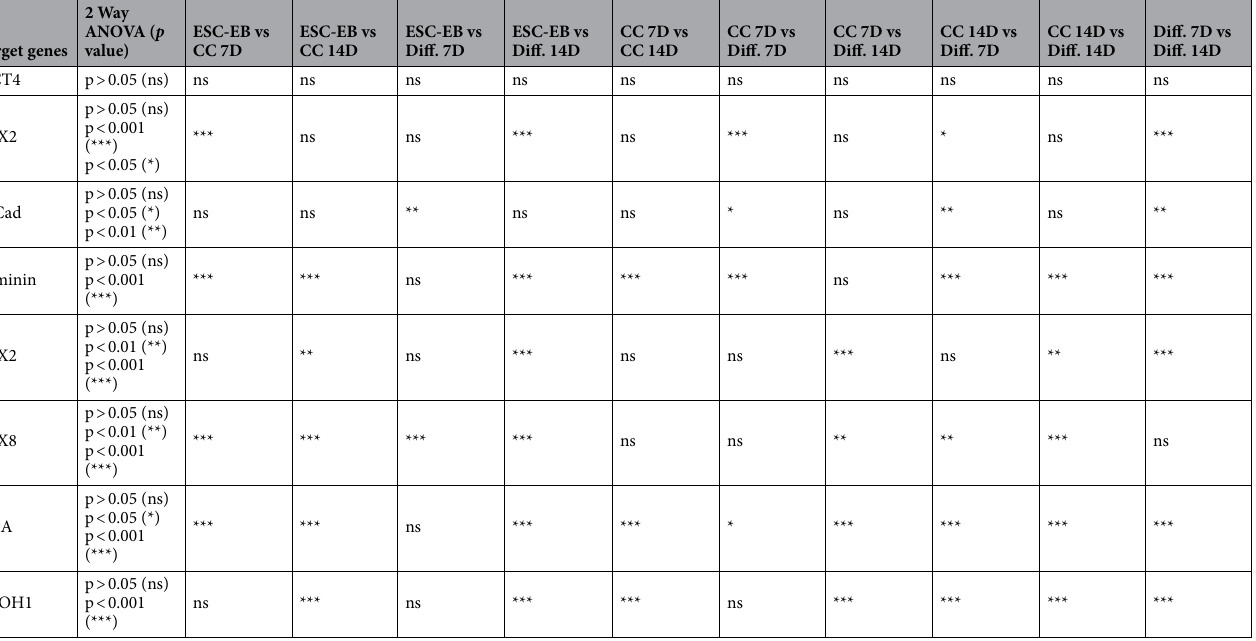
Table 1. Statistical analysis of levels of mRNA expression for HC differentiation-related genes using